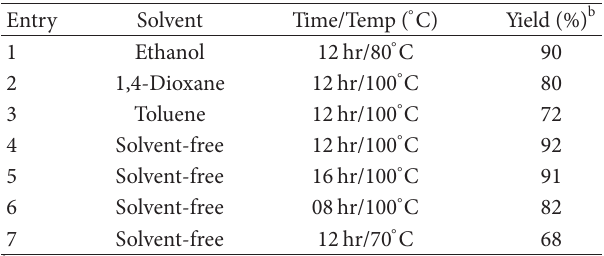
T 1: Preparation of 2-phenyl benzimidazole using various solvents and temperaures a